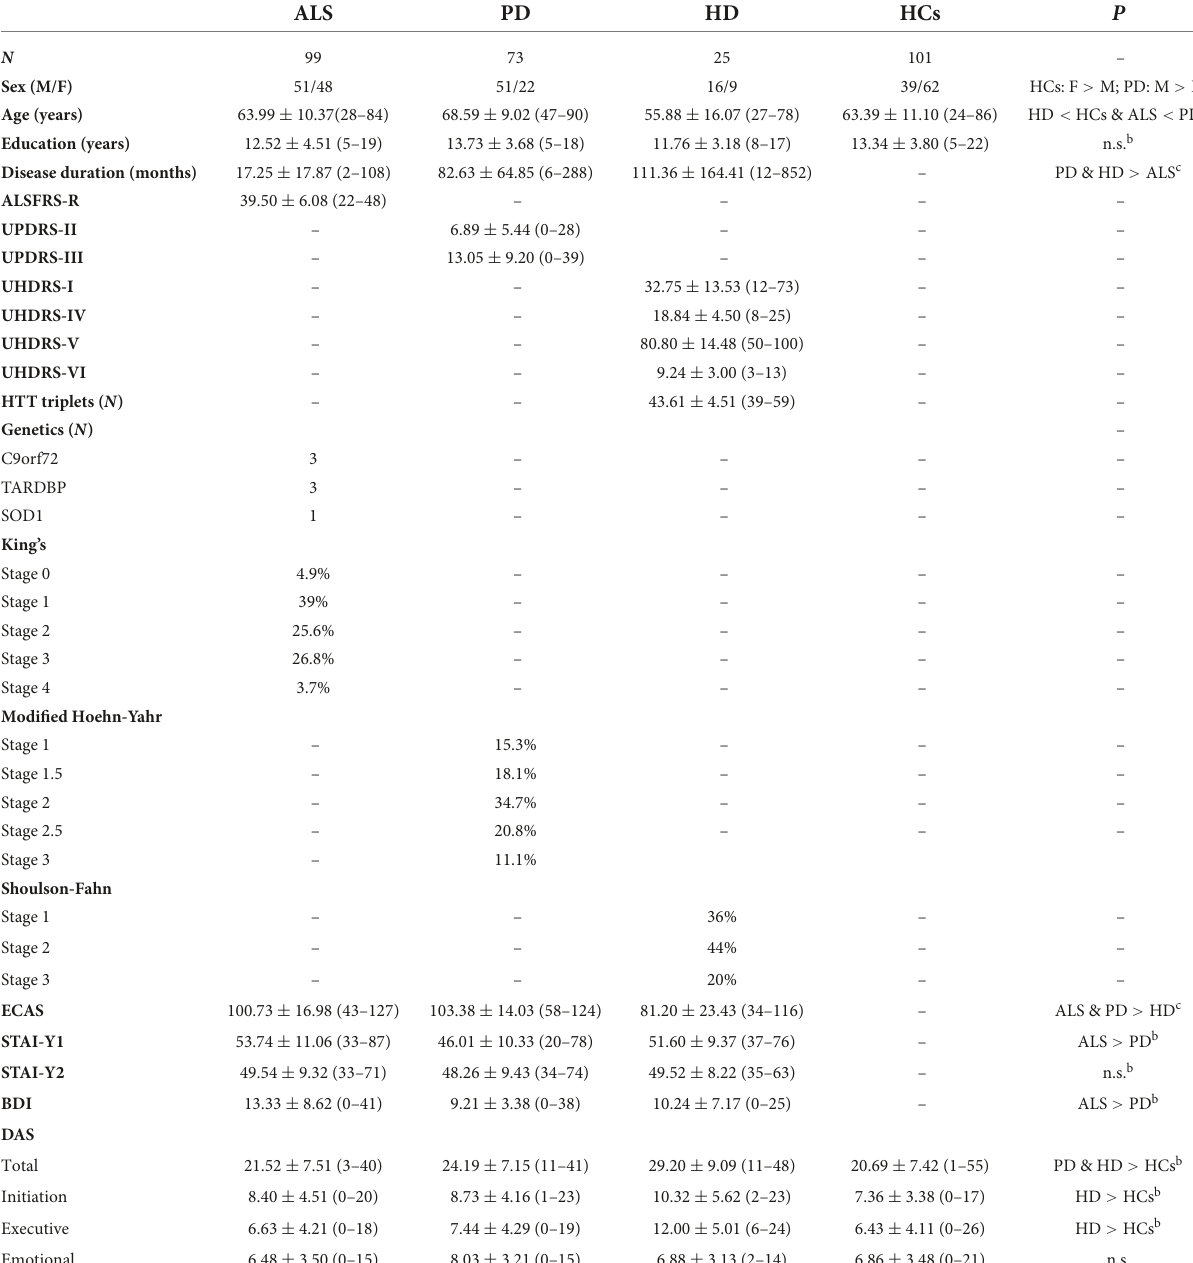
TABLE 1 Participants’ demographic and clinical